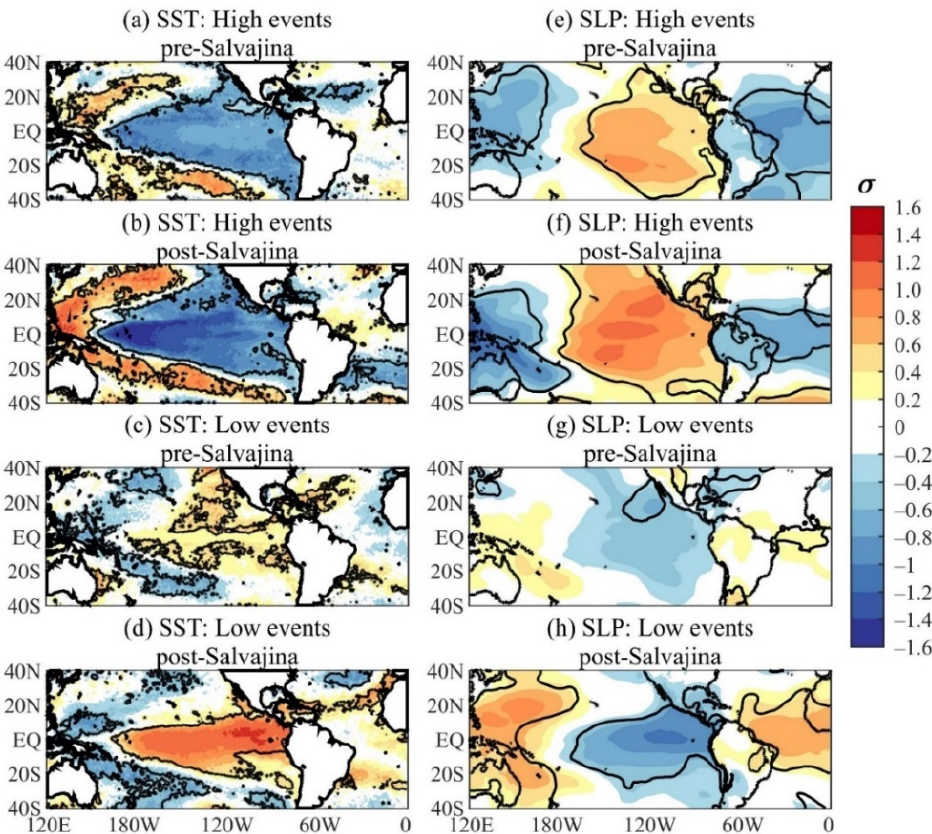
Figure 6. Standardized sea surface temperature (SST) anomalies associated with high discharge events ( a ) pre-Salvajina and ( b ) post-Salvajina, and low-discharge events ( c ) pre-Salvajina and ( d ) post-Salvajina. Standardized sea level pressure (SLP) anomalies associated with high discharge events ( e ) pre-Salvajina and ( f ) post-Salvajina, and low discharge events ( g ) pre-Salvajina and ( h ) post- Salvajina, at La Balsa station during November–January (NDJ). Shading interval: 0.2 SD. Continuous contours indicate significant values at a 95% confidence